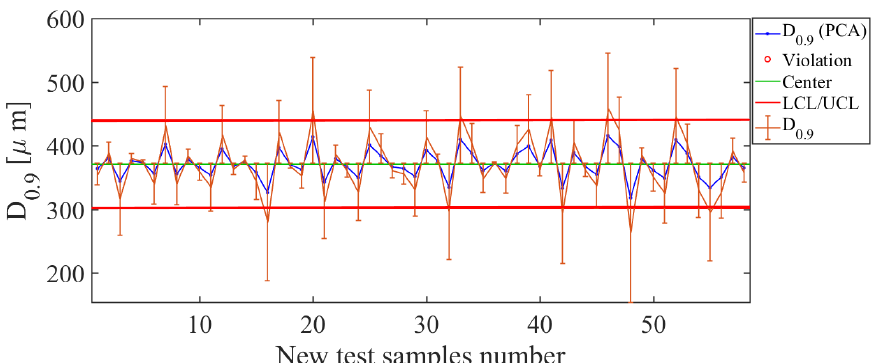
Figure 14. Soft-sensor responses (control chart and error bars) for the D 0.9 descriptor. For values in the range 300 µ m < D 0.9 < 500 µ m, it is observed that the soft sensor has the best estimation efficiency, since small error bars are